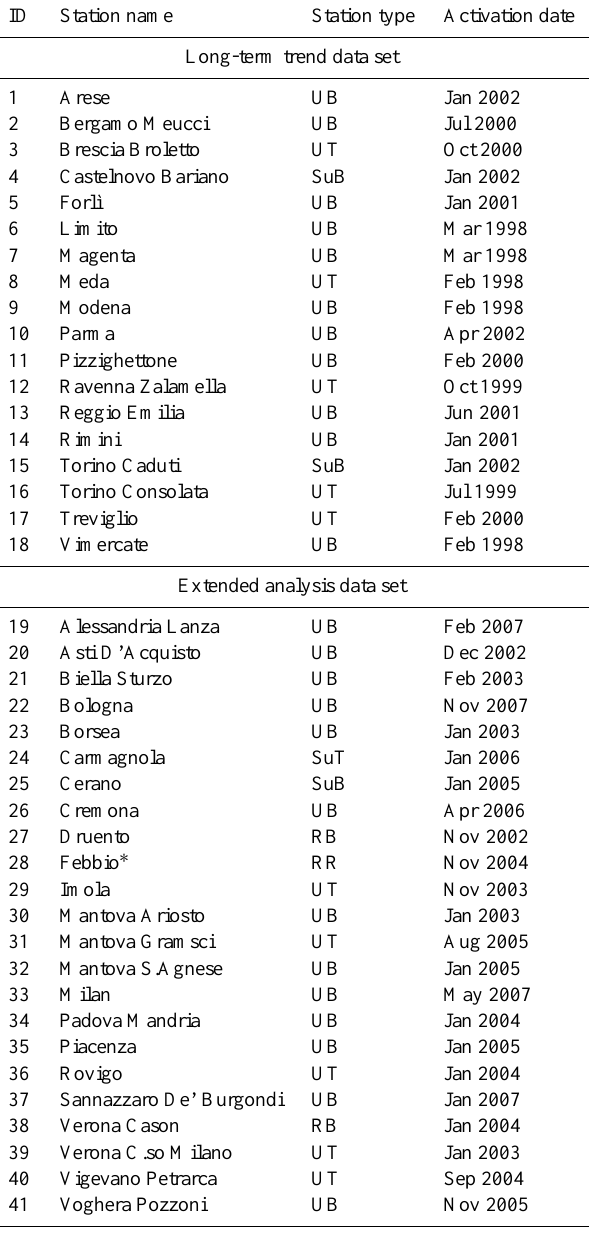
Table 1. Analysed PM 10 sampling sites for long-term trend and for extended statistical analysis. All sites have been active up to January traffic, SuB – suburban background, SuT – suburban traffic, RB – rural background, RR – rural remote.